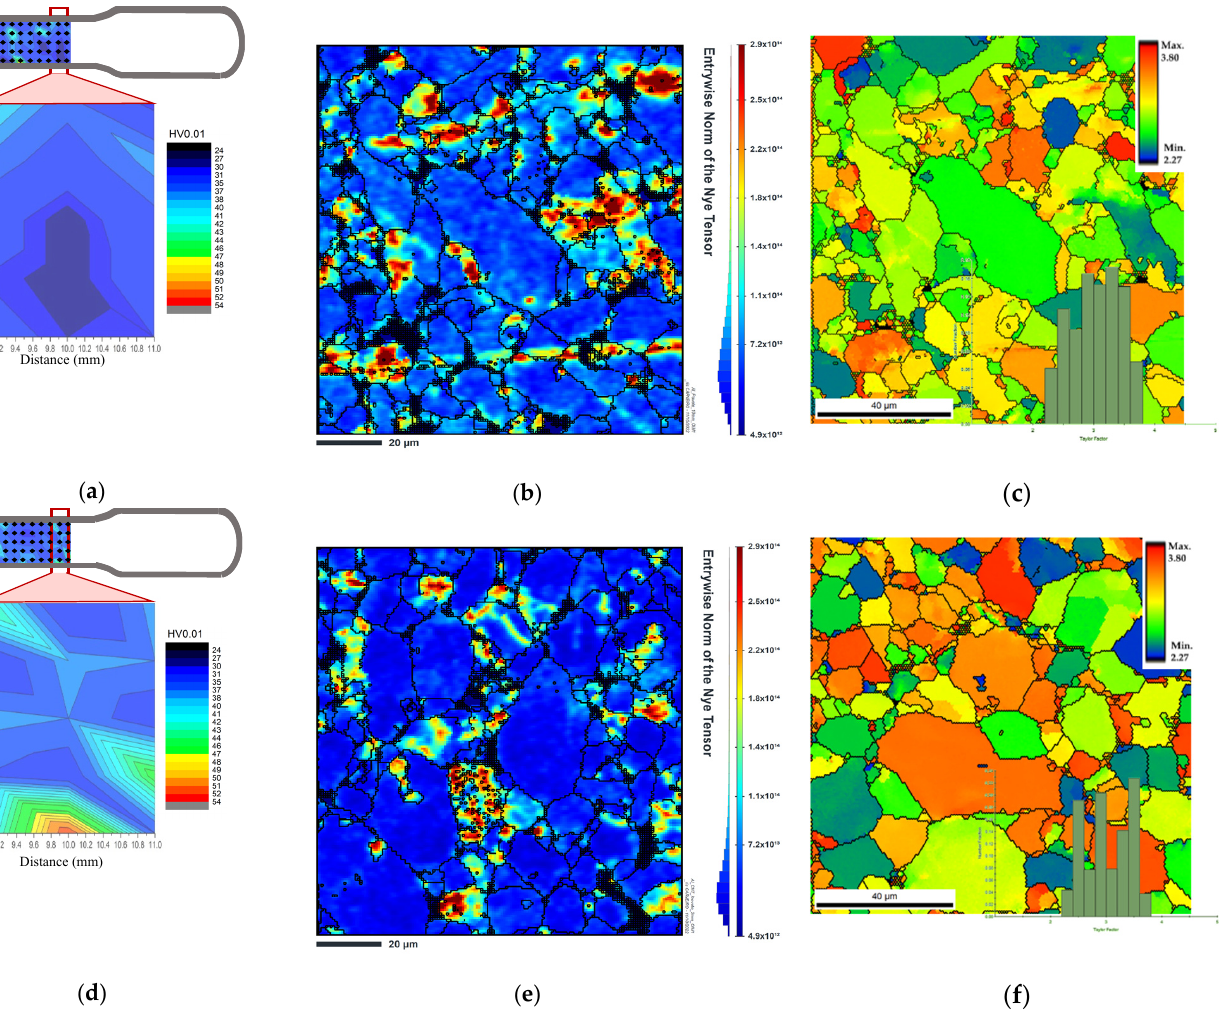
Figure 13 . Hardness distribution maps (HV 0.01) of ( a ) Al and ( d ) Al/CNT of fractured tensile test specimens and average geometrically necessary dislocations (GNDs) density and Taylor factor maps of ( b , c ) Al and ( e , f ) Al/CNT samples.